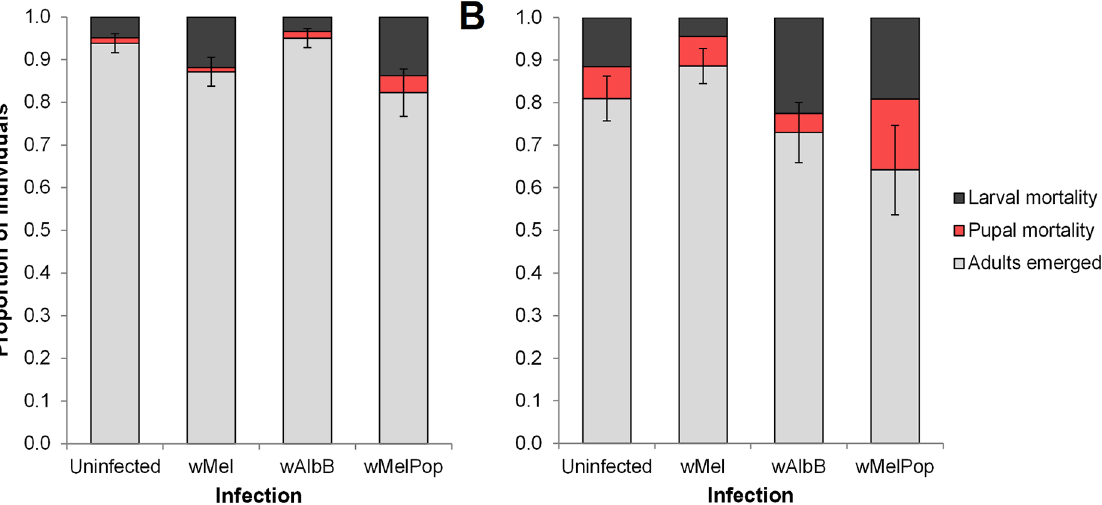
Fig 3. Proportion of Ae . aegypti larvae developing when fed ad libitum after extended food deprivation. Larvae were provided with TetraMin ad libitum after (A) 15 and (B) 25 days of food deprivation. Light grey bars denote the proportion of surviving larvae that reached adulthood, while black and red bars correspond to the proportion of larval and pupal mortality respectively. Error bars are standard errors for the proportion of larvae that survived to adulthood. Within treatments, no proportions differed significantly from each other ( P > 0.05, by Tukey ’ s honest significant difference test).